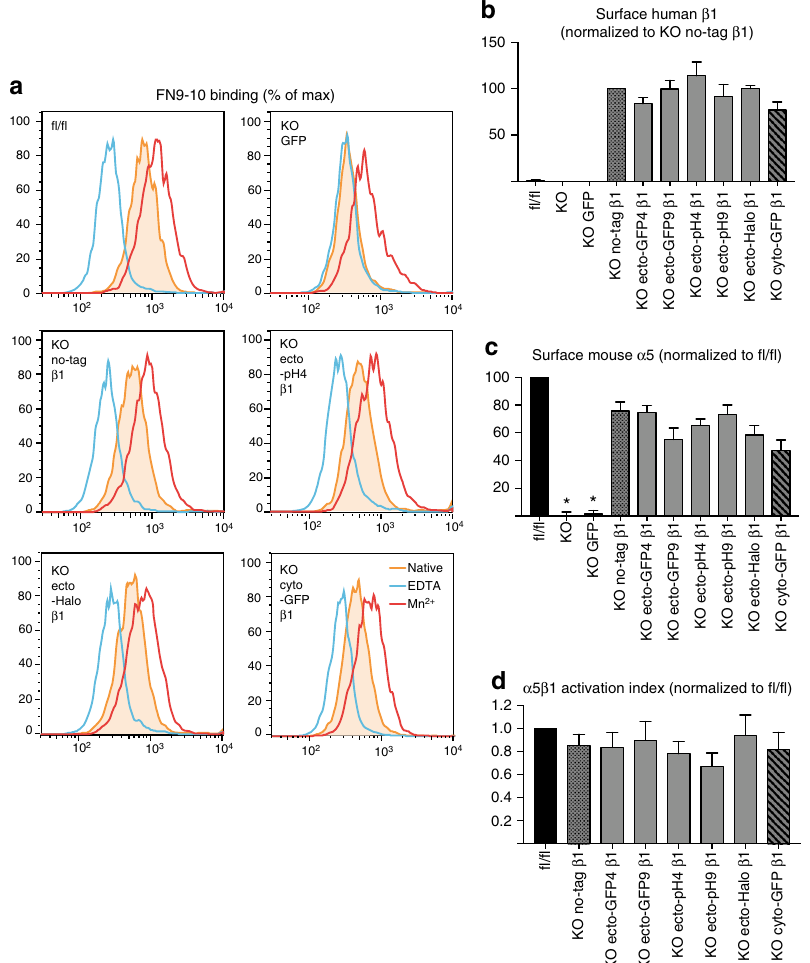
Fig. 4 Ecto-tagged β 1 integrins bind soluble ligand, restore surface levels of endogenous α 5 integrins, and display normal activation indices. a Flow cytometry histograms showing binding of soluble FN9-10 to parental and a subset of reconstituted KO fi broblasts, in native conditions ( fi lled orange peak ), EDTA-inhibited conditions ( blue peak ), or Mn 2+ -treated conditions ( red peak ). Full data set in Supplementary Fig. 3a. b , c Quanti fi cation of surface levels of human β 1 ( b ) and mouse α 5 integrins ( c ) measured by fl ow cytometry on parental and reconstituted β 1 integrin fl / fl and KO fi broblasts. d Activation index of surface α 5 β 1 integrins on parental and reconstituted β 1 integrin fl / fl and KO fi broblasts, calculated as (FN9-10 binding in native conditions — FN9-10 binding in EDTA-inhibited conditions)/surface levels of α 5 integrins. All data b – d is shown as mean ± SEM from four independent experiments. Statistical analysis was performed using one-way repeated measures ANOVA with Dunnett post hoc test. Each column was compared to KO no-tag β 1 and * p < were observed with FN-coated plates; however, in this case KO collagen (Supplementary Fig. 2c) and ecto-Halo β 1 integrins cells exhibited only ~50% inhibition in adhesion, and the β 1 cyto- localized in FA in HeLa cells also expressing endogenous β 1 GFP construct was unable to fully rescue adhesion (Fig. 3b). It is integrins (Supplementary Fig. 2d). Thus, inserting an ecto-tag into likely that, in the absence of α 5 β 1, KO cells adhere via α v β 3 or human β 1 integrin hybrid domain did not impair targeting to a α v β 5 integrins 38 , explaining the partial adhesion defect. To spectrum of adhesions on a range of integrin substrates.